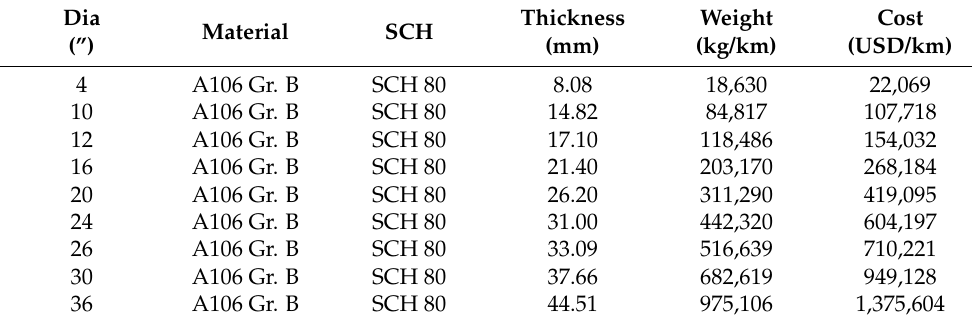
Table 3. Specifications of hydrogen pipelines based on Scenario